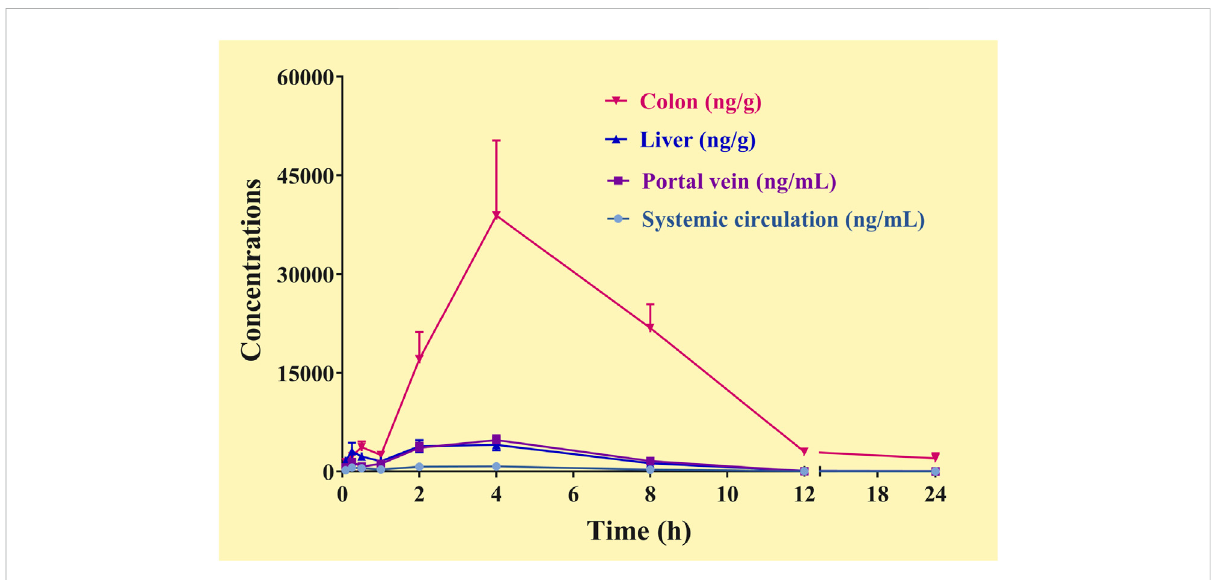
FIGURE 5 Concentration-timecurveofthe “ integratedconstituent ” intheplasma(thesystemiccirculation, theportalvein)andtissue(theliver, thecolon) samples of the mice received the oral Gegen - Qinlian decoction at the dosage of 6.1 g/kg (mean ± SD, n = 6).